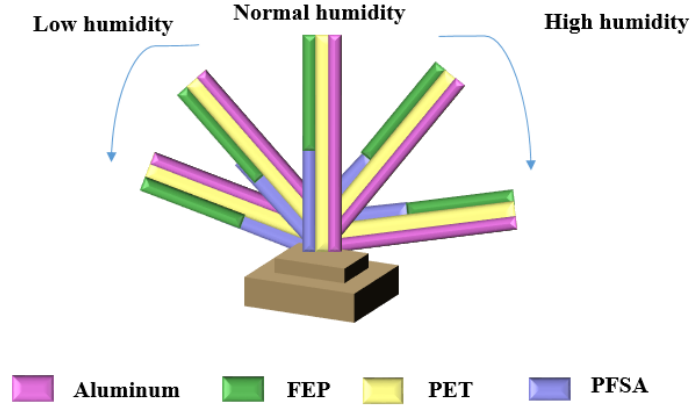
Figure 22. The schematic special humidity actuator by